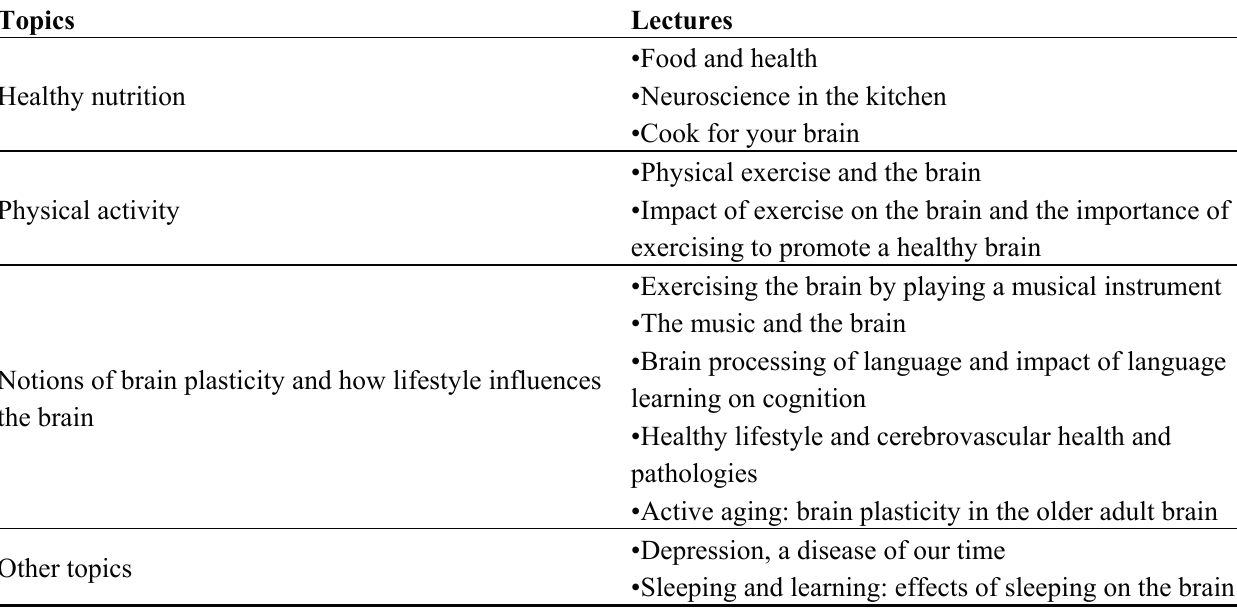
Table 1. Summary of topics and lectures included in the